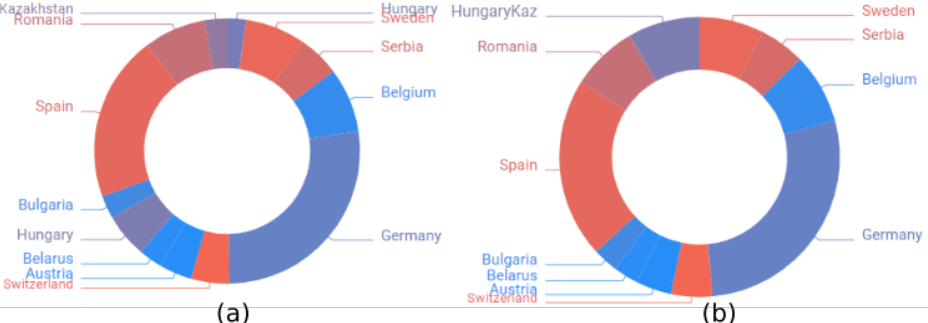
Figure 12. Example of removing overlap by merging two labels : ( a ) before use; ( b ) after